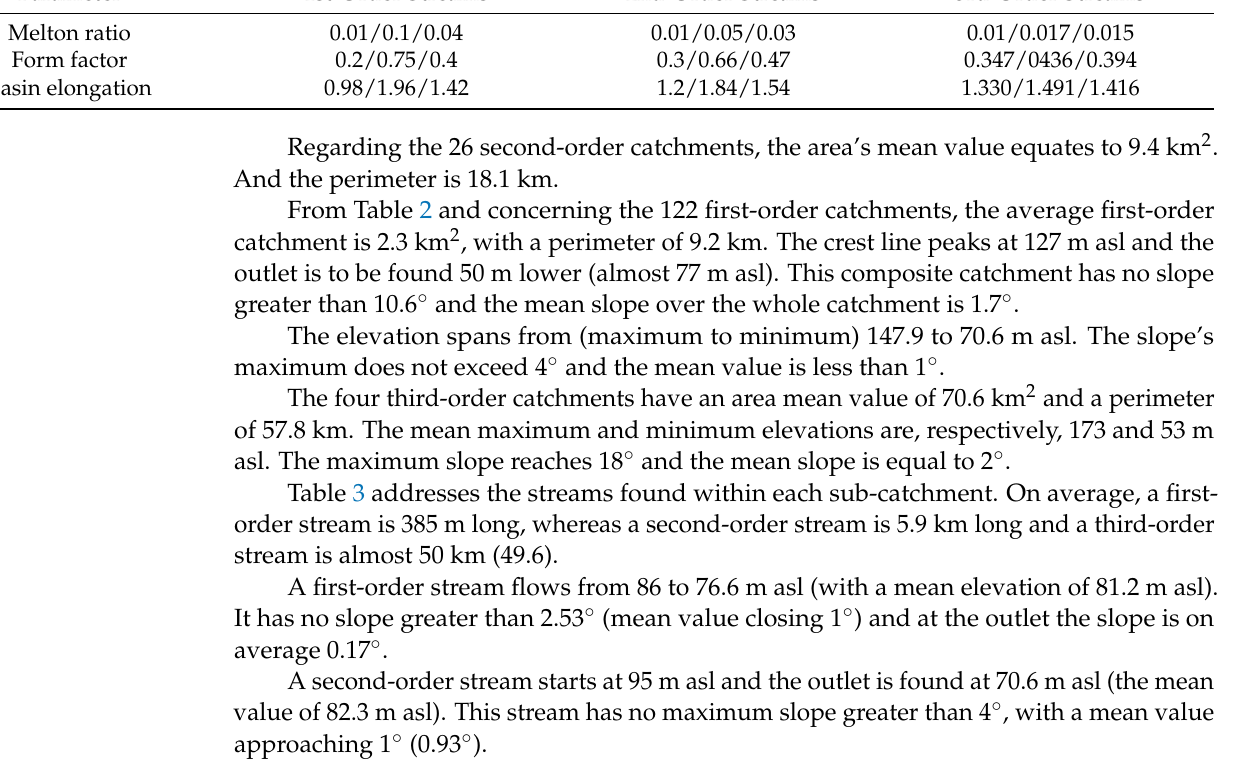
Slope min Table 4. Morphometrical results associated with catchments that encompass Melton ratio, form factor and basin elongation. Parameter Melton